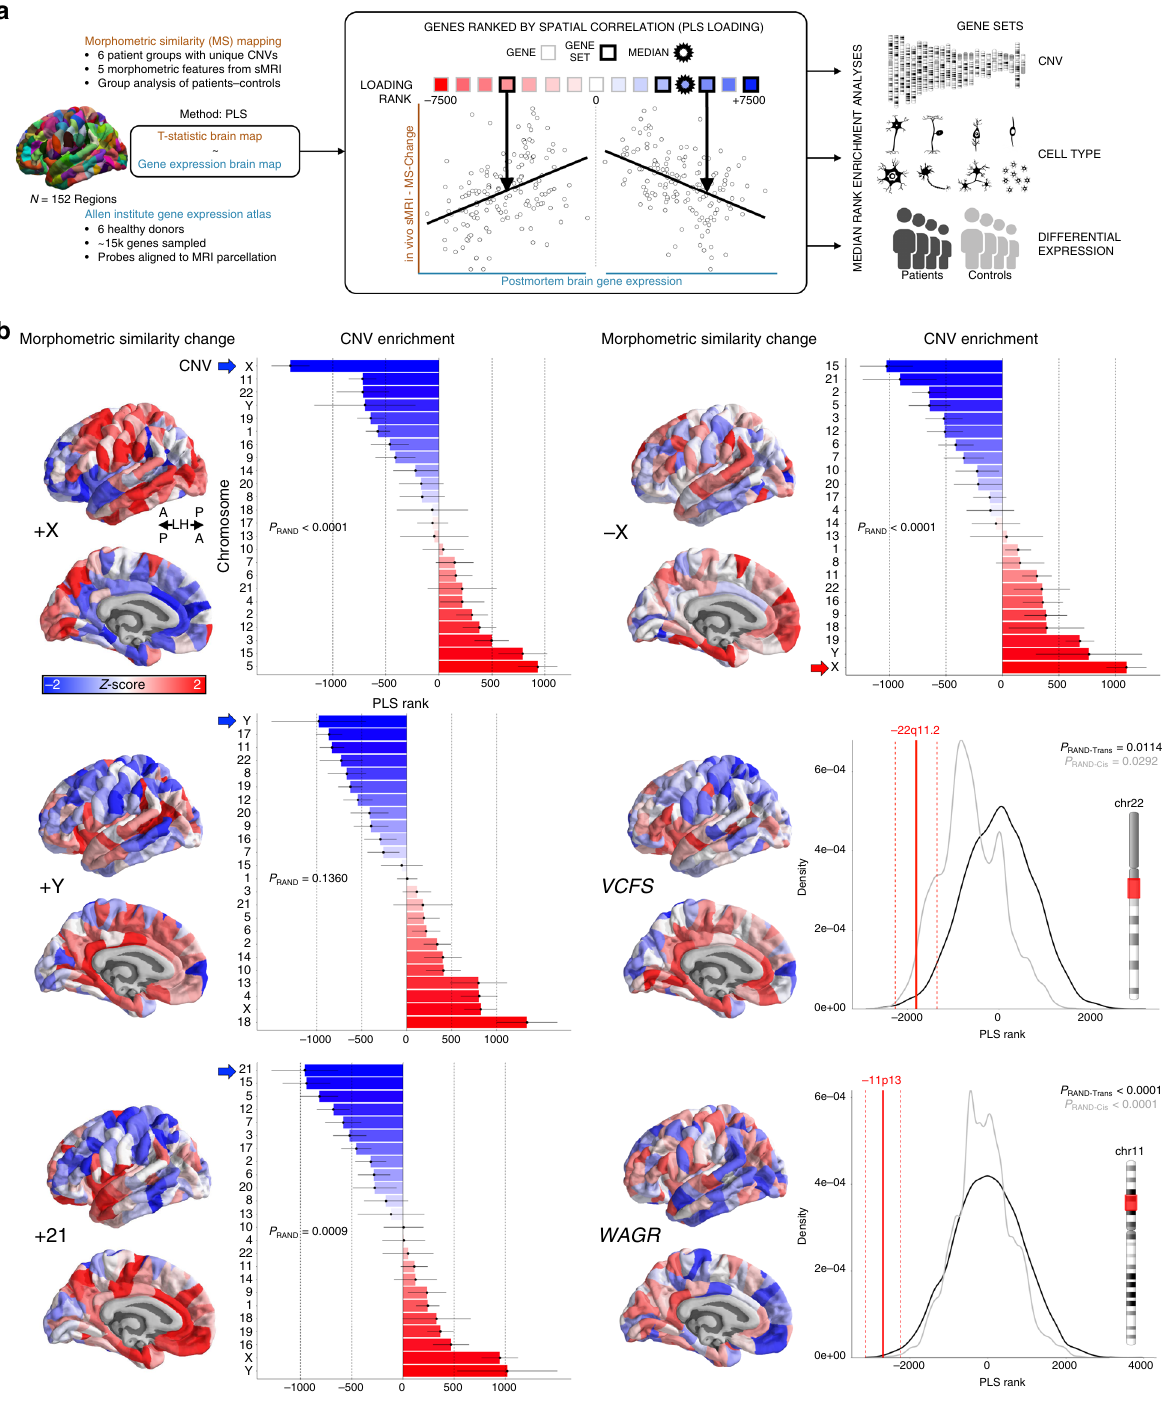
Fig. 1 Transcriptomic speci fi city of neuroanatomical effects. a Schematic outlining the main imaging-transcriptomic enrichment analyses and statistical tests. b (left) Surface projections of T-statistics ( z -scored for plotting purposes) for CNV effects on regional morphometric similarity (MS). Despite some overlap across CNVs, each CNV induces a distinct pro fi le of MS change. For full chromosome CNVs, neighboring point range plots show the median (point) and standard error (range) rank of each chromosomal gene set — based on gene rankings from the PLS analysis (see ( a ), N genes per chromosome provided in Supplementary Dataset 3). The chromosomal gene set for each CNV possessed a more extreme median rank than all other chromosomal gene sets, and the polarity of this effect was opposite for chromosomal duplications (CNV gene set high ranked) versus deletion (CNV gene set low ranked). For subchromosomal CNVs (depicted as red in the respective chromosome ideograms), density plots show median (solid line) and standard error (dashed line) ranks for the relevant CNV gene set. Observed ranks are shown relative to two null distributions: P RAND-Trans (black), and P RAND-Cis (gray). P RAND was calculated using 10,000 gene rank permutations (black). P RAND-Cis was calculated similarly to P RAND-Trans but only sampling gene ranks from the respective chromosome of the CNV. All permuted P values were not further corrected for multiple comparisons, and were determined based on one-sided tests of gene set enrichment (median rank; see “ Methods ”